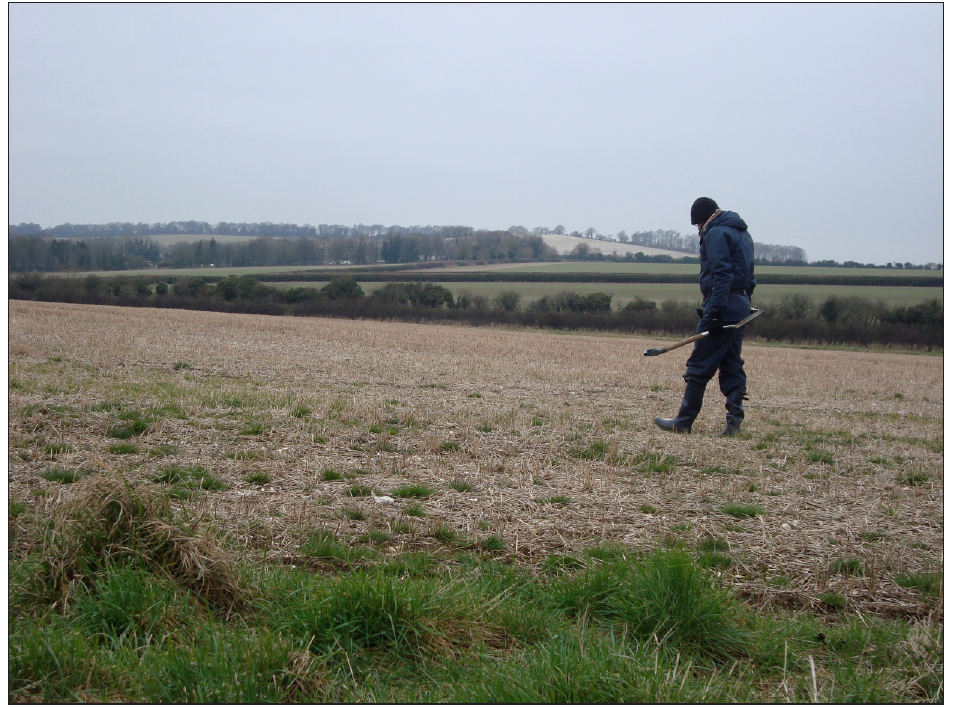
Figure 5: An interviewee metal detecting, January